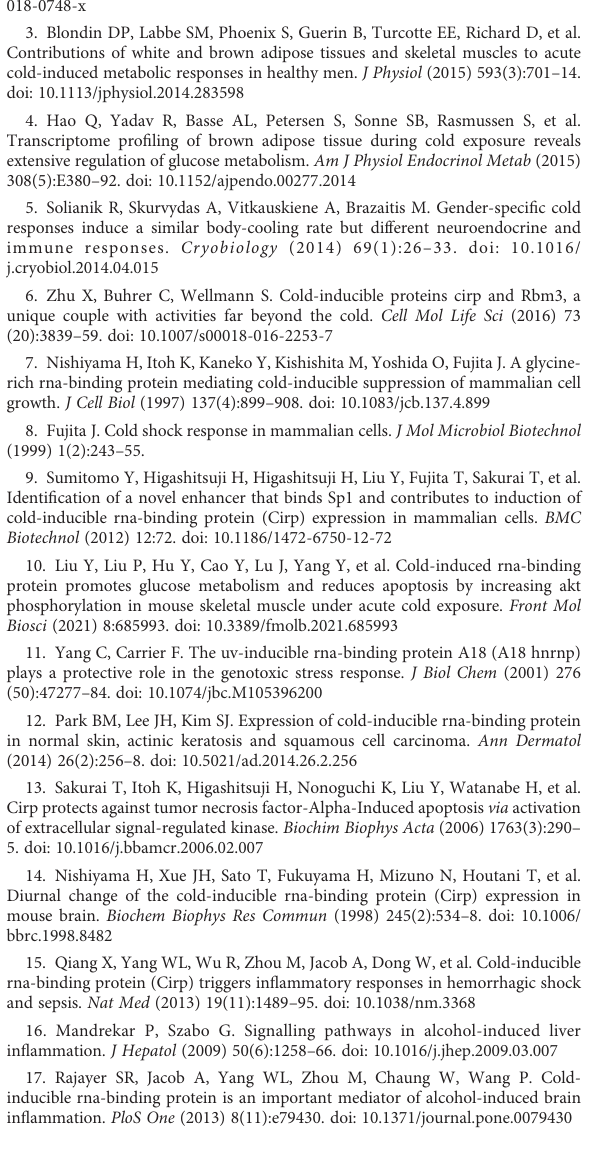
were transfected with the mock vector (pGL4.23 vector), major A allele of the rs11170509, rs11170516, rs35437931, rs7962345, rs12828860, rs11170510, and rs58123204 or minor G allele of the rs11170509, rs11170516, rs35437931, rs7962345, rs12828860, rs11170510, and rs58123204-luciferase reporter constructs. Cells were subjected to a luciferase assay. Experiments were repeated at least three times. Graphs areindicativeofthemean±standarddeviation(SD).**p<0.01(two-tailed unpaired Mann –